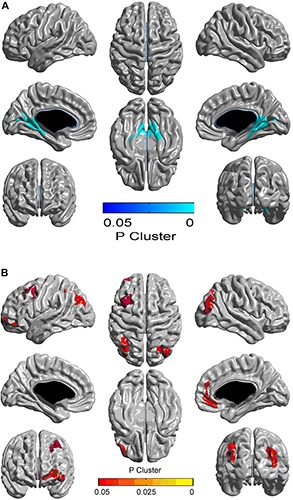
Alterations in cortical thickness in young male patients with childhood-onset adult growth hormone deficiency. Clusters with FWE-corrected p < 0.05 are shown, and the color corresponds to the p-value. Areas in blue represent decreased cortical thickness in AGHD compared to controls, and yellow area represent increased thickness. (A) Clusters of significantly reduced cortical thickness in the AGHD group compared to controls. (B) Clusters of significantly increased cortical thickness in the AGHD group compared to controls.